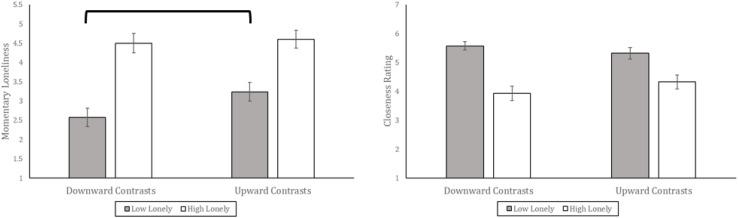
Momentary loneliness (single-item measure) and closeness to one’s closest friend as a function of downward vs. upward contrasts and initial loneliness (UCLA Loneliness scale score). These are group means and the error bars are standard error. The bracket indicates a finding within the Low Lonely group of contrast direction affecting loneliness at p = 0.05.